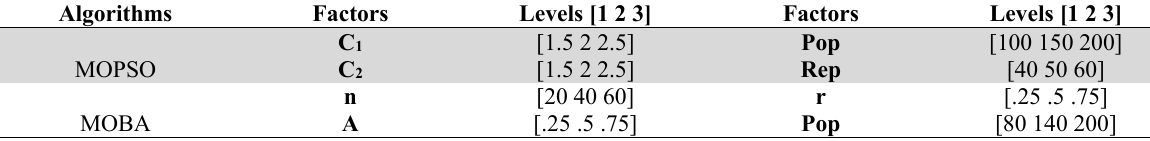
Parameter values and levels of MOPSO and MOBA (WIP inventory model)